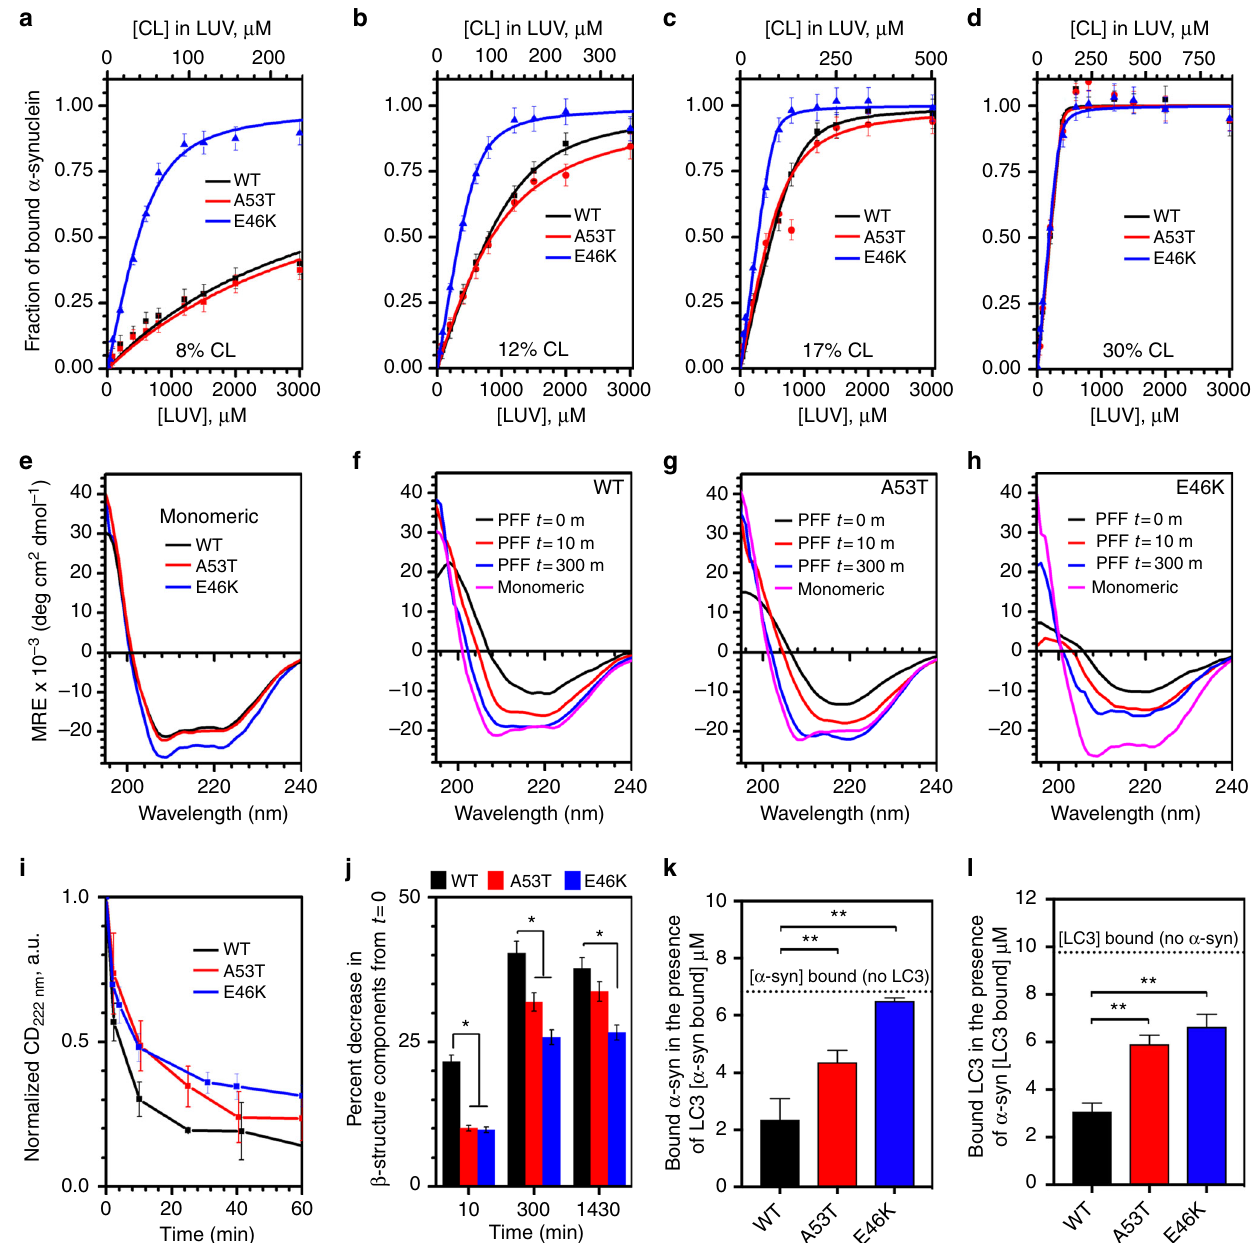
Fig. 5 Cardiolipin promotes refolding of α -syn fi brils. a – d Binding of WT, A53T or E46K α -syn monomers to OMM-like LUVs, with increasing molar ratios of CL, was measured by CD spectroscopy and the 222 nm signal was used to calculate the fraction of bound α -syn. Data are plotted as change in fraction of bound protein vs. the total concentration of LUVs (bottom axis) or the total concentration of cardiolipin in the LUV (top axis). Binding parameters were calculated by fi tting the data to Eq. 1 (Methods) and are reported in Supplementary Table 1. e Representative CD spectra of the monomeric WT, A53T or E46K α -syn in the presence of 1.2 mM LUVs containing 30% CL. f – h Refolding of WT ( f ), A53T ( g ) or E46K ( h ) α -syn preformed fi brils in the presence of 1.2 mM LUVs containing 30% CL was monitored at multiple time points by CD spectroscopy to follow the redistribution of the secondary structural components (from primarily β -structures to primarily α -helical structures). The magenta line shows the CD spectra of the monomeric WT, A53T or E46K α -syn in the presence of 1.2 mM LUVs as a reference standard. i Change in CD signal at 222 nm collected as a function of time. Kinetic data were fi tted by exponential decay and the calculated rates of refolding were 3.79 ± 0.46 h − 1 vs. 2.44 ± 0.42 h − 1 vs. 1.30 ± 0.49 h − 1 for WT, A53T and E46K α -syn, respectively ( P < 0.05). j Relative decrease in the β -structure components determined by deconvolution of CD spectra presented in f – h . Data represent mean ± s.e.m. * P < 0.05 by ANOVA, followed by Dunnett post hoc test, n = 3. k , l WT, A53T or E46K α -syn (10 μ M) was incubated with 0.5 mM LUVs containing 30% cardiolipin in the presence or absence of equimolar LC3 protein and concentration of α -syn bound to LUVs ( k ) or LC3 bound to LUVs ( l ) was determined by fl otation assay. Pleated line indicates the amount of LUV bound α -syn in the absence of LC3 ( k ) or the amount of LC3 bound in the absence of α -syn ( l ). Data represent mean ± s.e.m. ** P < 0.01 by ANOVA, followed by Dunnett post hoc test, n =